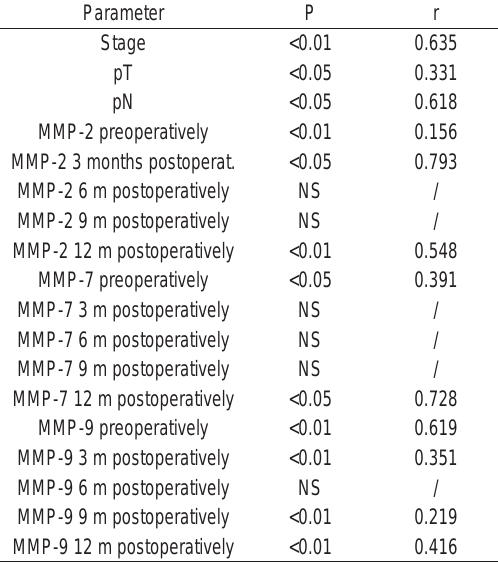
TABLE 4. Statistically signifi cant correlations with poor out- come in CRC